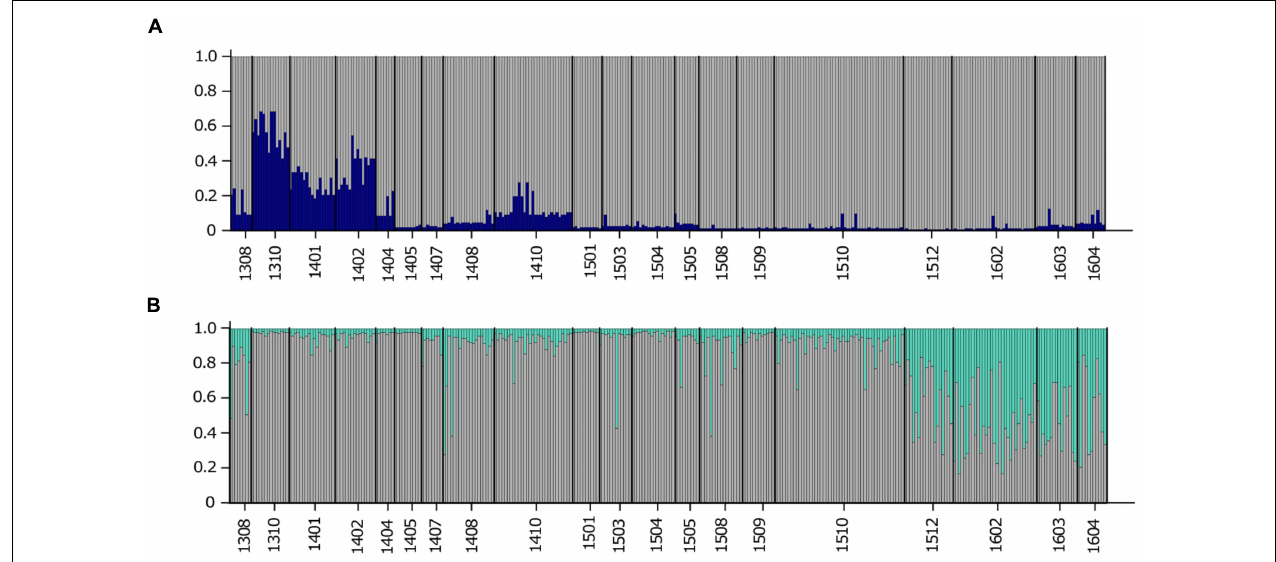
FIGURE 4 | (A) STRUCTURE output for K = 2 from the high-resolution sampling period at USVI based on three microsatellites discovered from the transcriptome (G.caribT5, G.caribT6, and G.caribT7). (B) STRUCTURE output for K = 2 from the high-resolution sampling period at USVI based on the five microsatellites that did not display any sudden changes in allele frequencies (G.carib1, G.carib2, G.carib3, G.carib4, and G.caribT6).